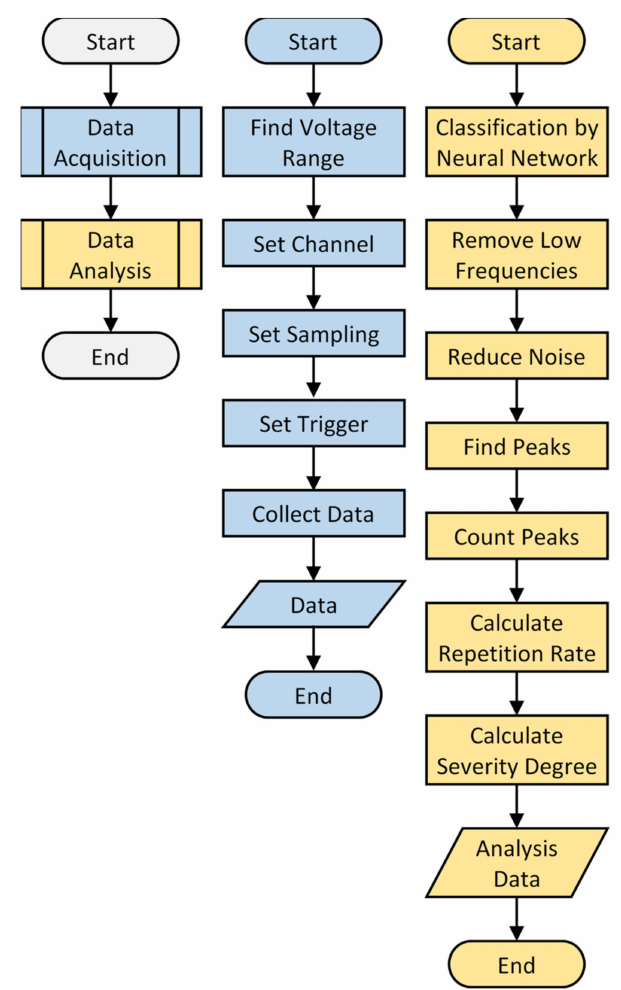
Figure 1. Flowchart of the implemented